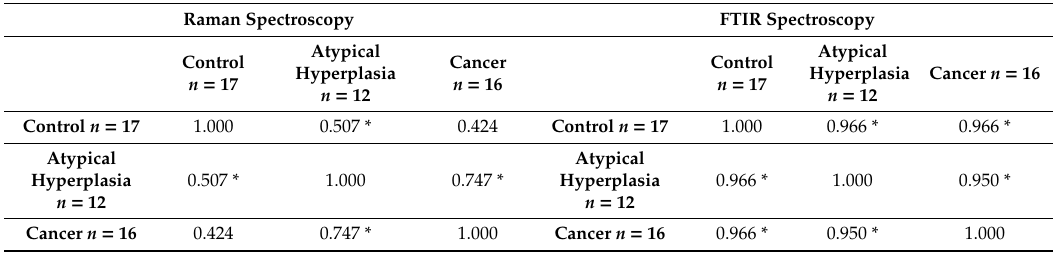
Atypical Control Hyperplasia Cancer n = n = 17 n = 12